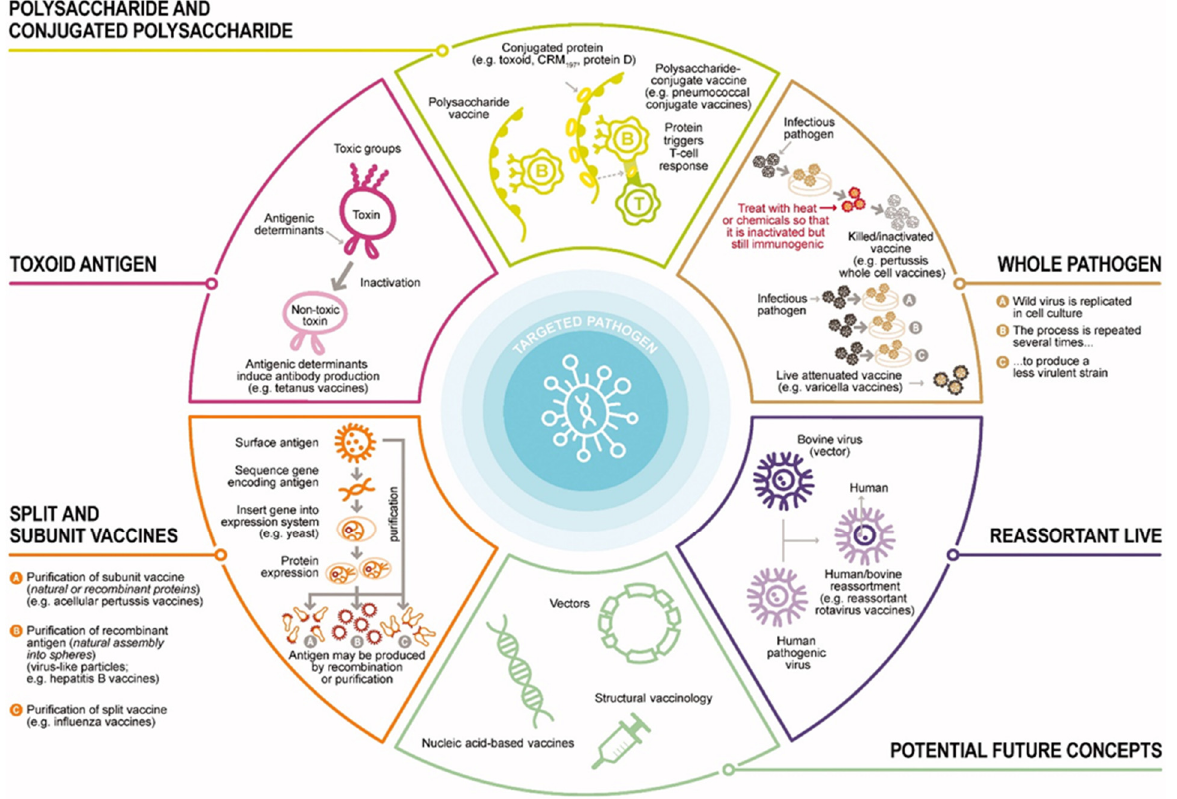
Figure 5. Types of vaccines being developed. Vaccines can contain live, whole pathogens, inactivated pathogens, toxoids, and parts of the pathogen. Novel concepts include vectors as delivery systems, and nucleic acid-based vaccines. Reprinted from [158]. CC-BY 4.0 (https://creativecommons.org/licenses/by/4.0/), accessed on 21 January